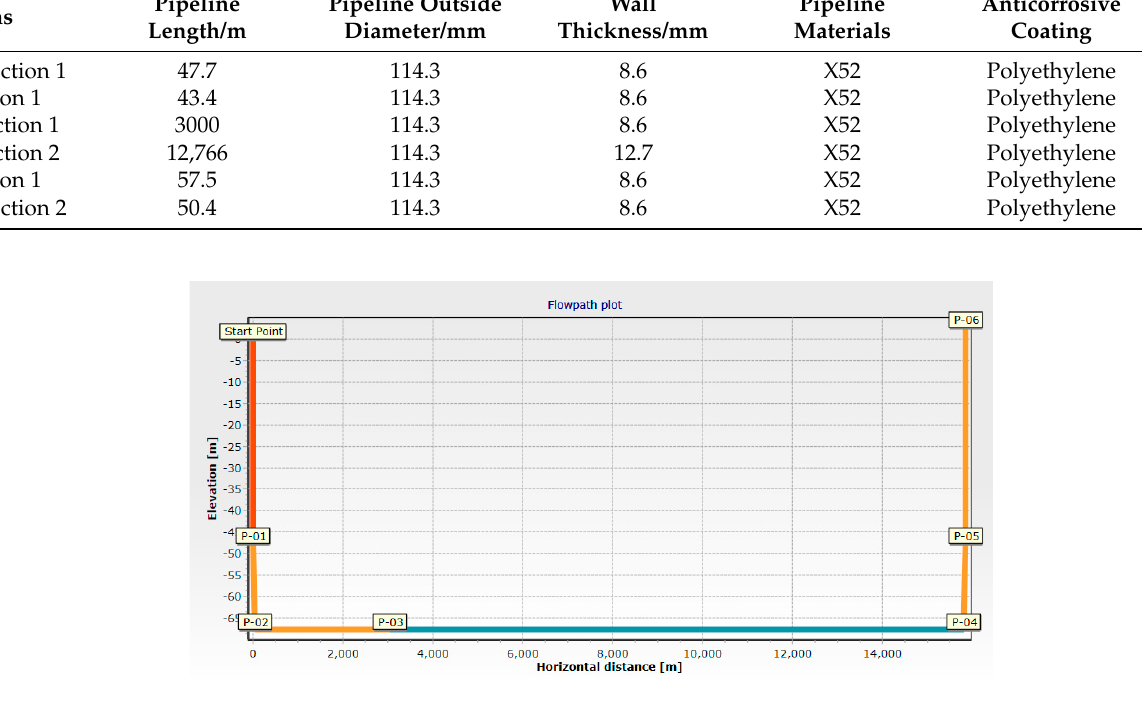
Figure 1. Pipeline flow path plot.